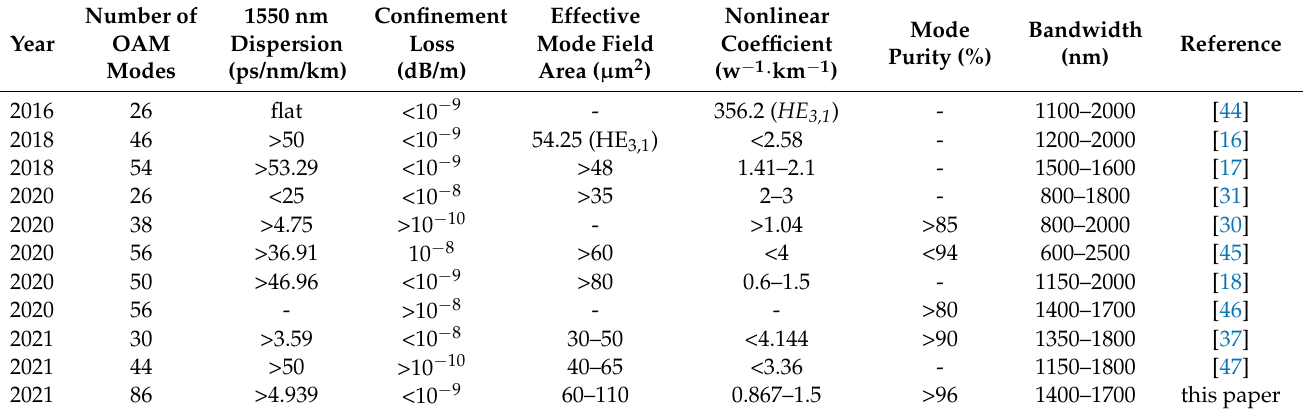
Table 3. OAM fibers based on PCF structures.